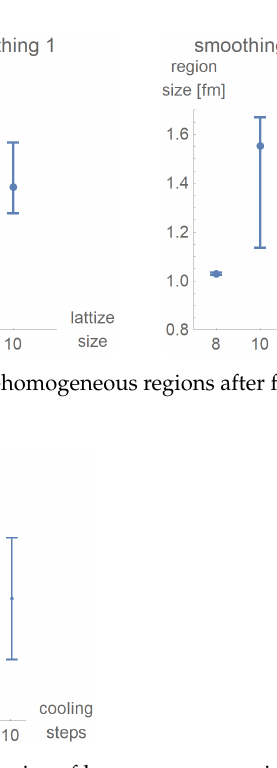
Figure 18. The S2-homogeneity along the vortex surface is compared for different lattice sizes and smoothing procedures after 10 cooling steps. The vortex detection mostly failed, and only a minority of the data collected could be used.